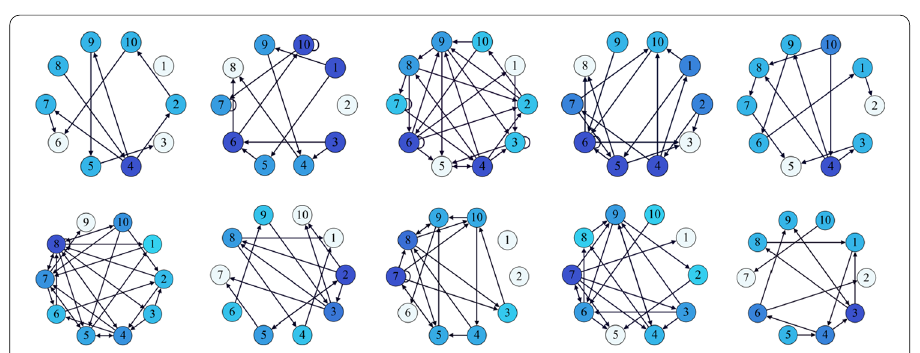
Fig. 2 Graphs of 10 sequential random